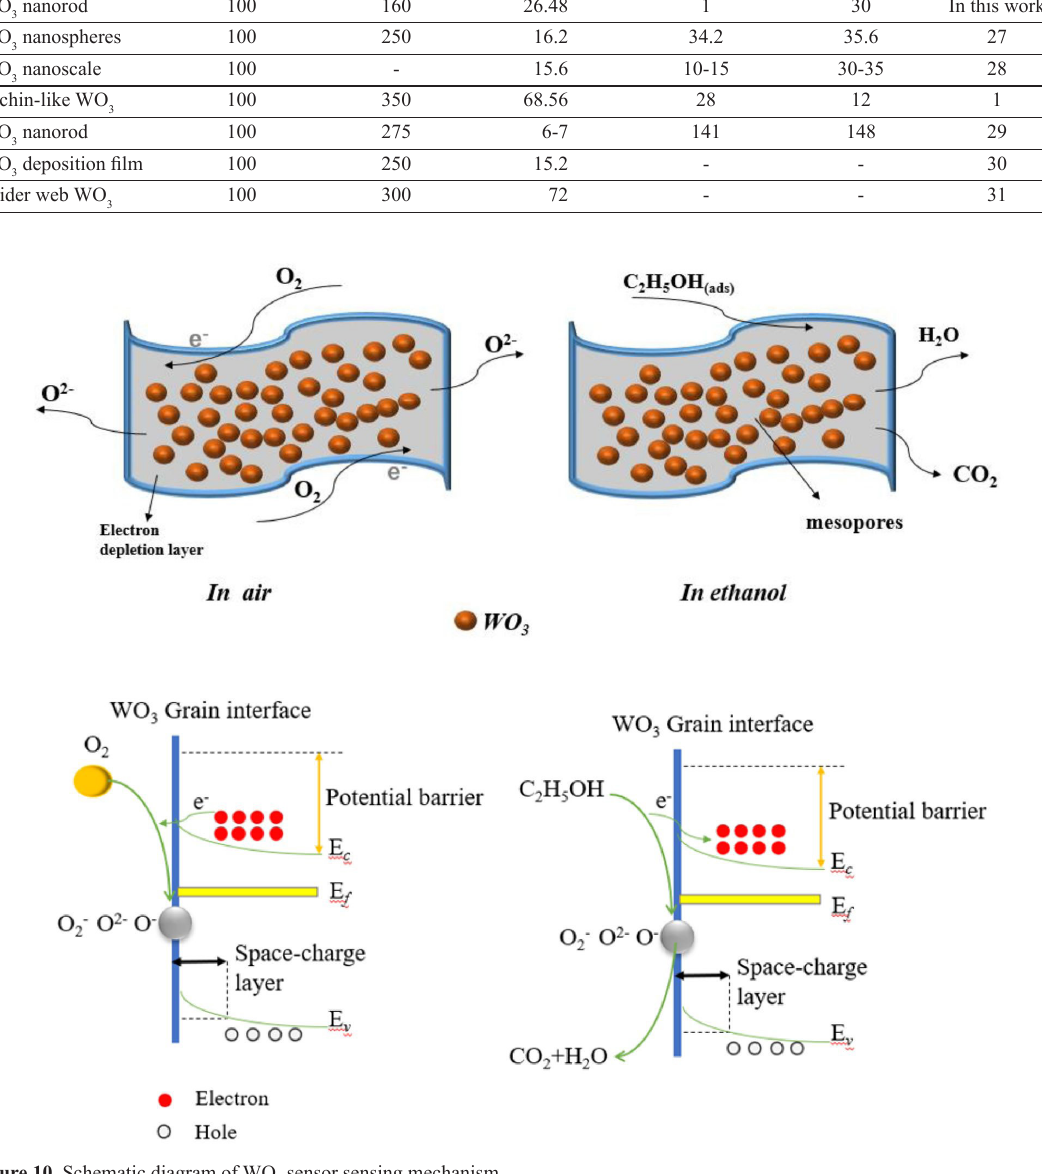
Figure 10. Schematic diagram of WO